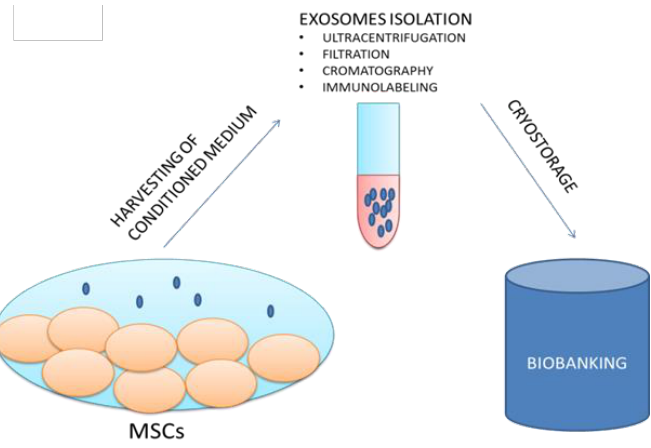
Figure 2. The proposed NANOBIOME approach.